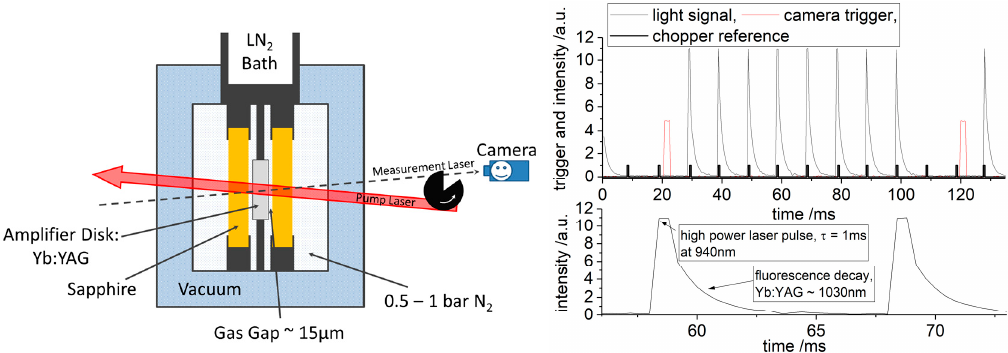
Figure 7. Left: Schematic depiction of the experimental setup for 100 Hz pumping trials of a cryogenically cooled Yb:YAG disk amplifier. The trigger wheel blocks and opens alternately the pump laser and the low power diagnostic laser. Right: Applied trigger regime and detected light pulse signal. The camera not only detects the pump light but also the florescence light from the amplifier disk and, therefore, detection of pump light on the camera has to be prevented.